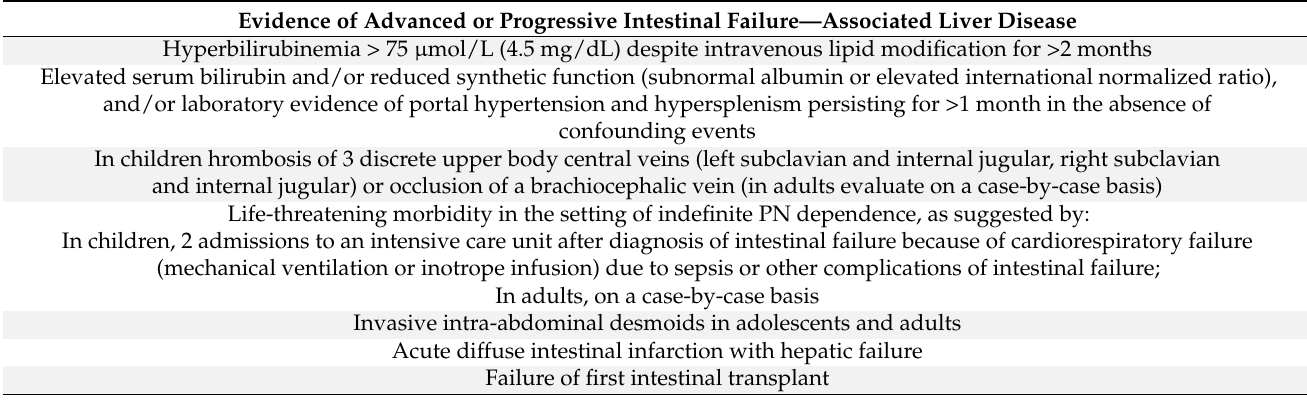
Table 2. Indications for intestinal transplantation adapted from ESPEN guidelines [76].